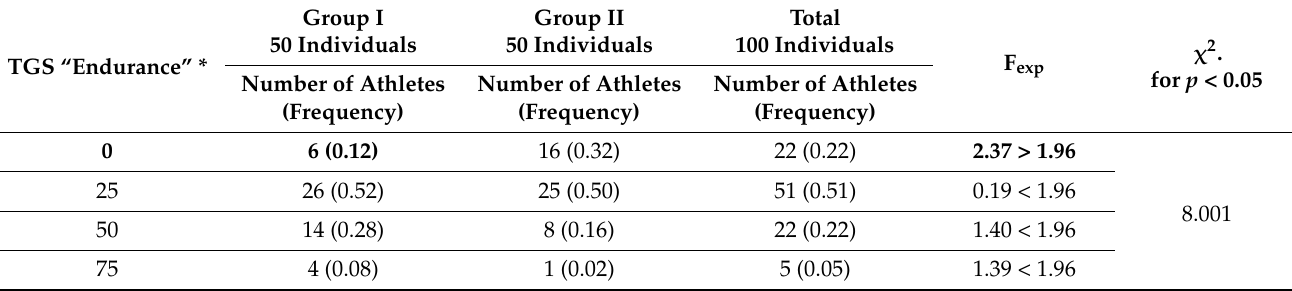
* Comparison of unrelated samples (TGS of athletes between Group I with high qualification and Group II with low qualification) was carried out by Fisher’s test, Fisher’s F-test standard is 1.96 ( p = 0.05). Evaluation of the relationship between two variables (qualification and TGS) was carried out using the chi-square test ( χ 2); the critical value of χ 2 at the significance level p = 0.05 is 7.815, the significance level p = 0.046; significant differences are highlighted in